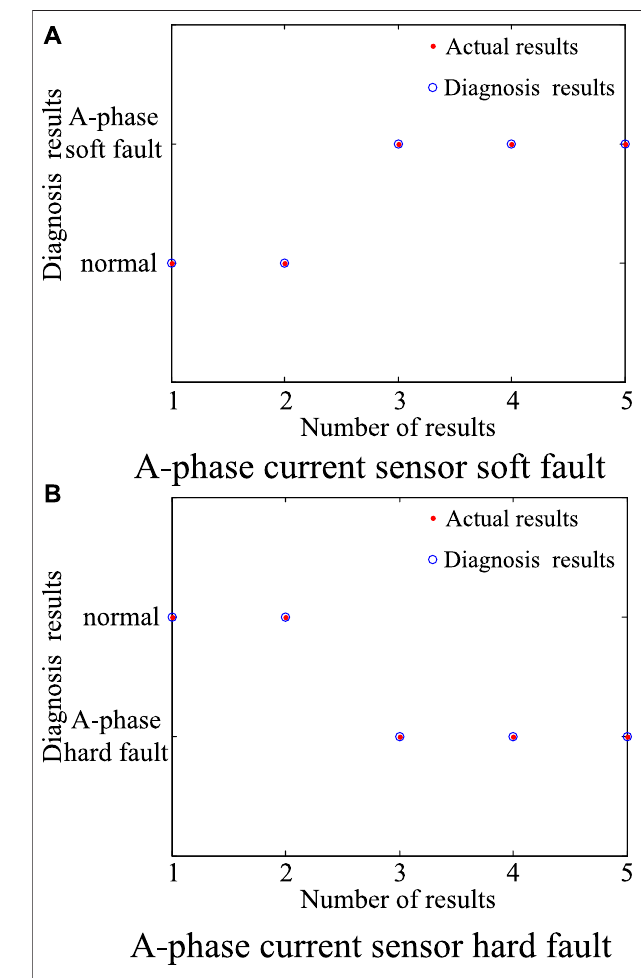
FIGURE 14 | Fault diagnosis results with a single current sensor